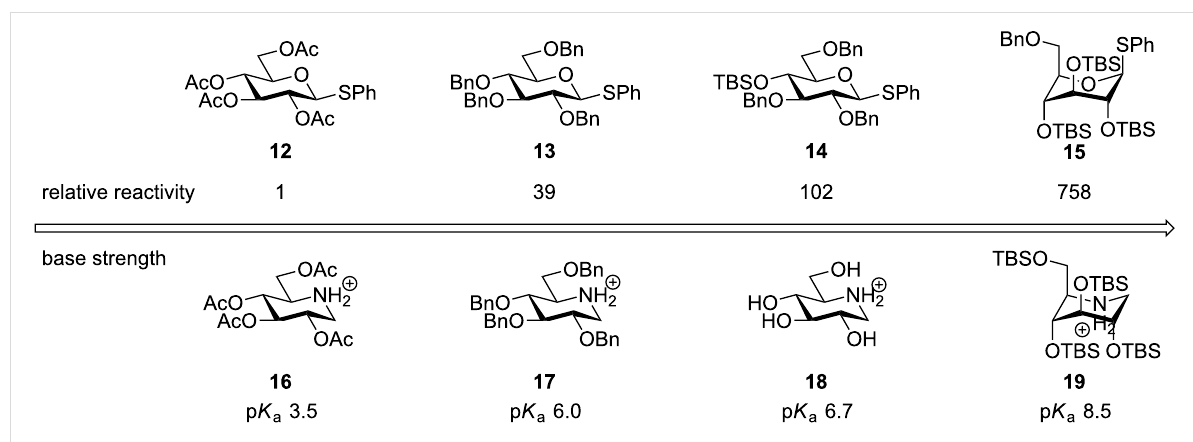
Figure 2: Comparison of the reactivity of glycosyl donors with the p K a of the corresponding piperidinium